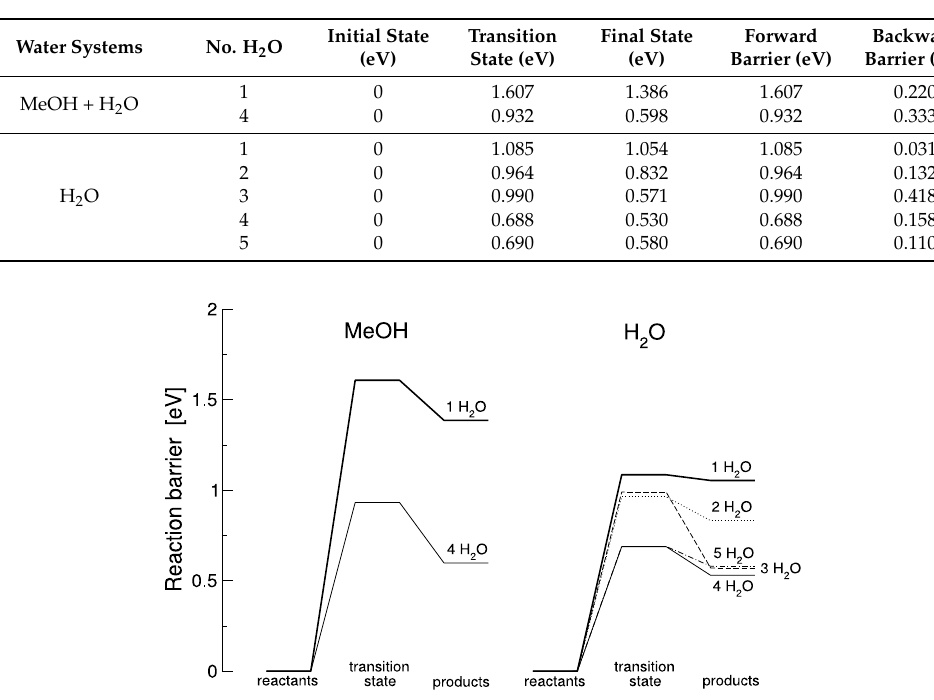
Table 3. Reaction barriers for the MeOH assisted and pure H 2 O dissociation in the presence of varying amounts of additional water molecules.